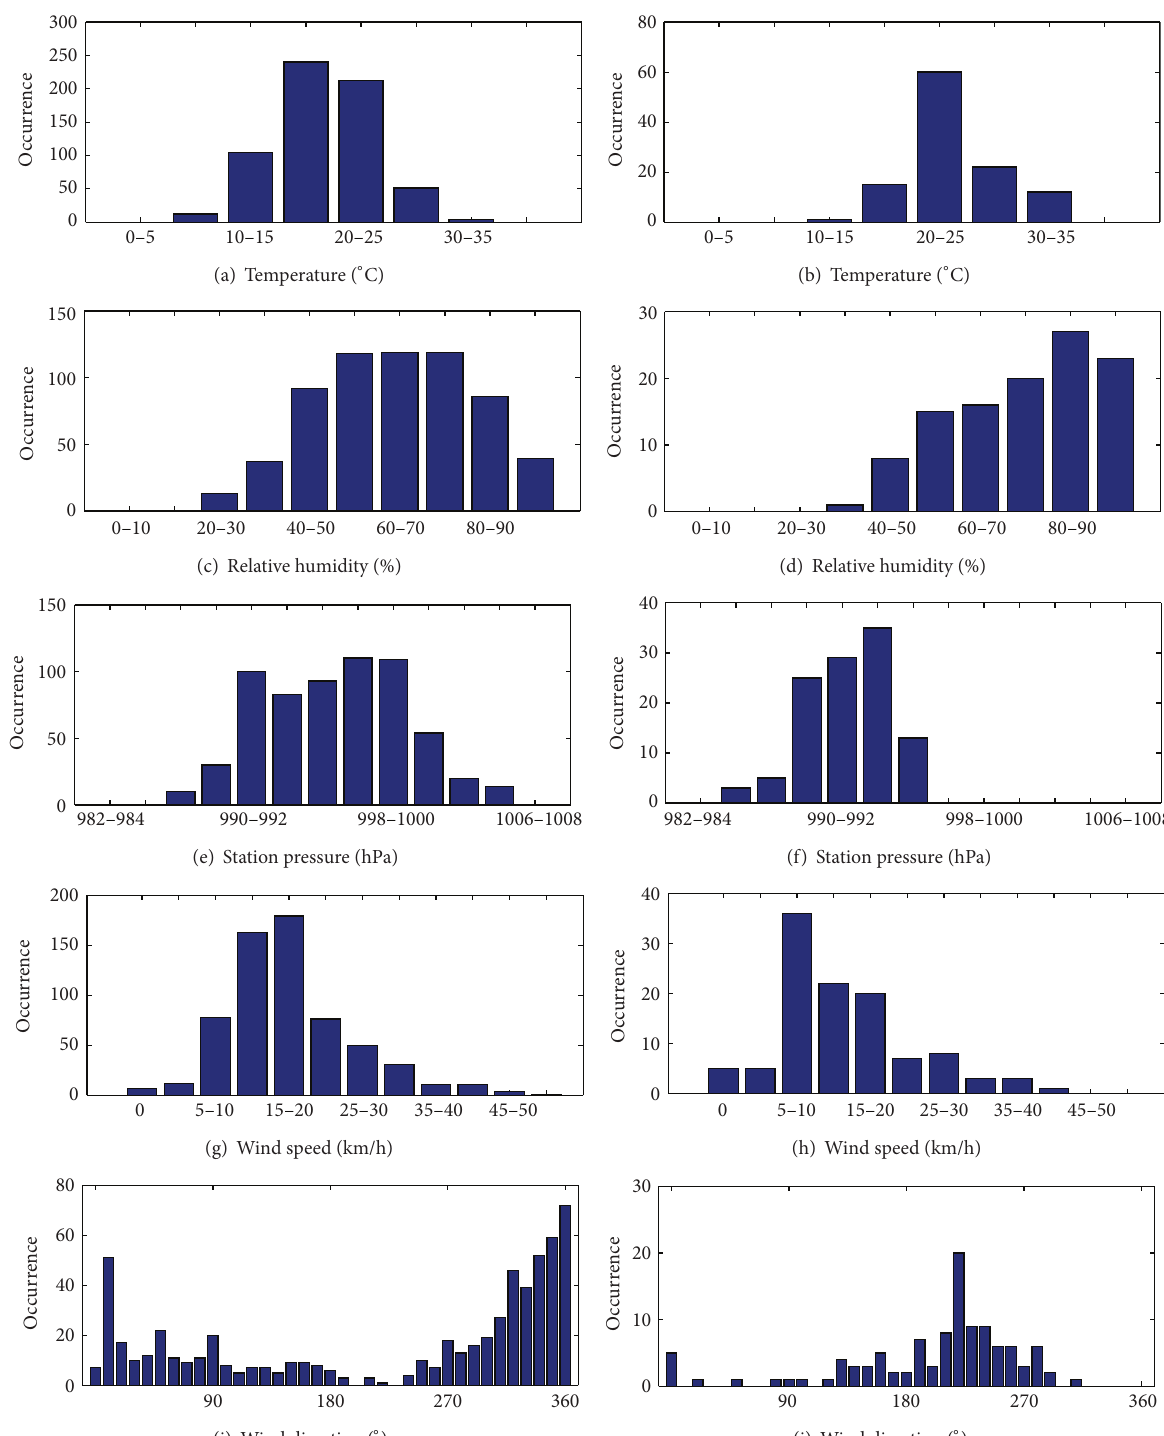
Figure9:Left:occurrencedistributionofthesurfacemeteorologicalconditionsatTorontoin2006summerwhenhourlyPM 2.5 was < 5 𝜇 g/m 3 . Right: the same as on the left, but when hourly PM 2.5 was > 35 𝜇 g/m 3